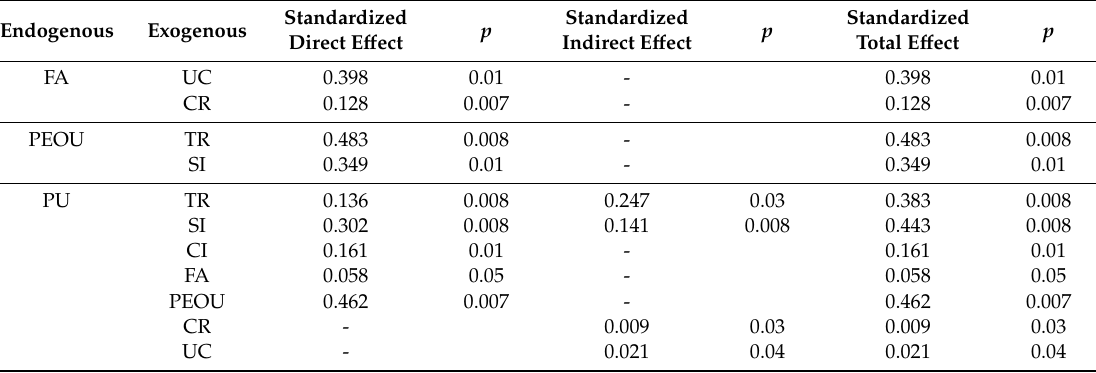
Table 6. E ff ects of exogenous variables on endogenous variables in IoT acceptance